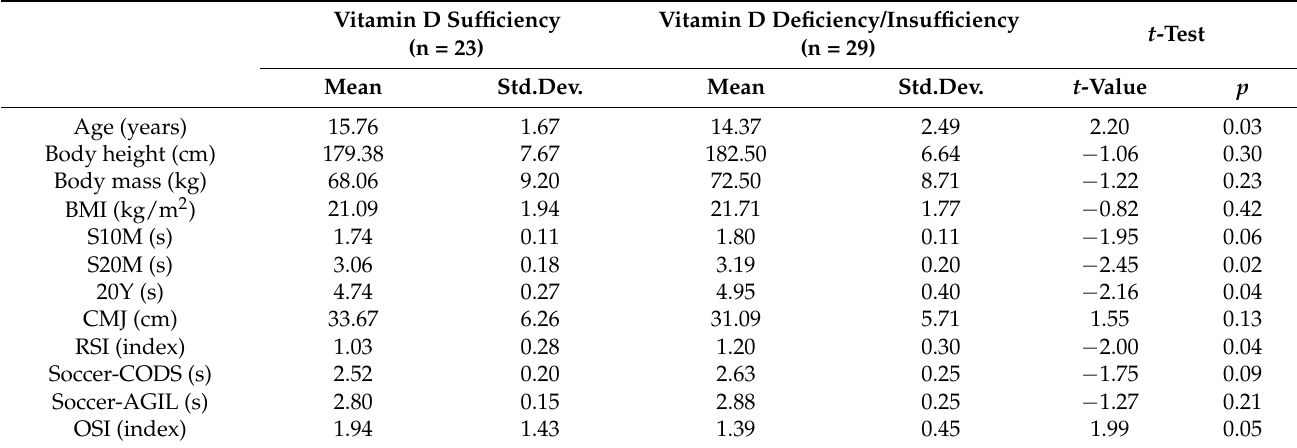
Table 2. Descriptive statistics and t -test differences between groups based on vitamin D status. Vitamin D Sufficiency 黄芳 (n =